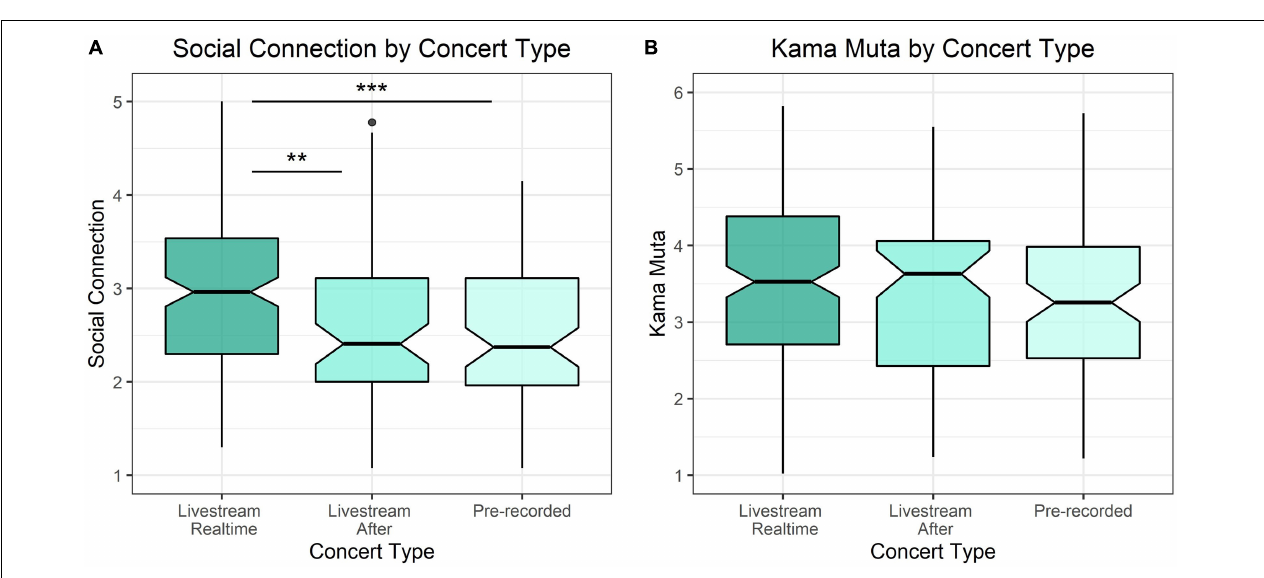
FIGURE 2 | The effect of concert liveness on (A) social connection and (B) kama muta . ** p < 0.01 and *** p < 0.001.